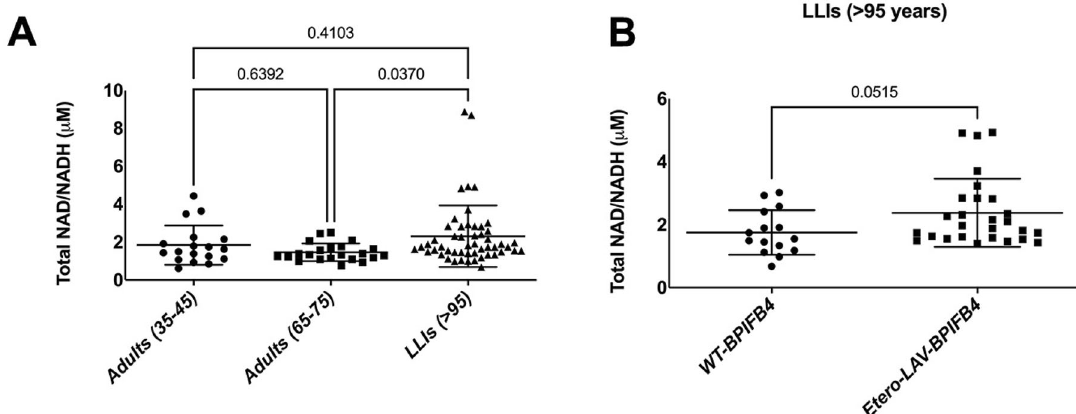
Fig. 6 High NAD + circulating levels might protect Long-living individuals. A Panel shows the total NAD/NADH levels in plasma from control volunteers of different ages ( n = 18 adults aged 35 – 45, and n = 22 adults aged 65 – 75) and LLIs ( n = 52, aged > 95) expressed as mean ± SD. Individual P values are shown. Statistical evaluation was carried out by ordinary one-way ANOVA corrected for Tukey ’ s multiple comparisons test (GraphPad ® Prism). B Panel shows total NAD/NADH plasmatic levels following genotype strati fi cation of LLIs in n = 15 WT-BPIFB4 carriers and n = 27 Etero-LAV-BPIFB4 carriers. Results are expressed as mean ± SD and individual P values are shown. Statistical evaluation was carried out by a two-tailed unpaired t- test (GraphPad ®